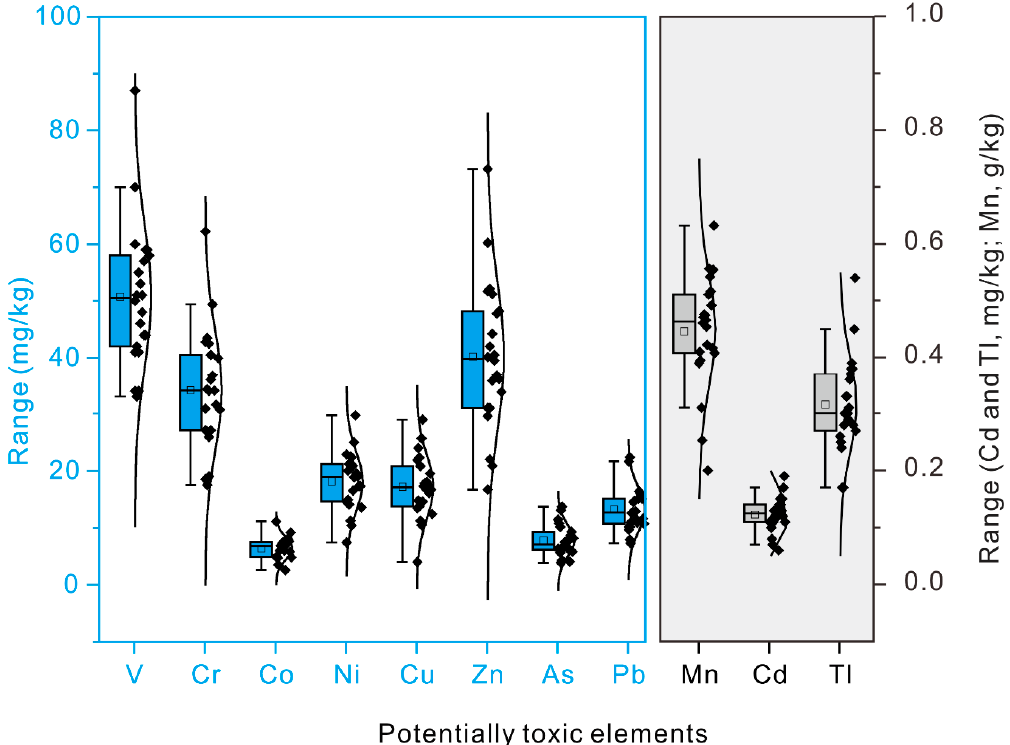
Figure 2. Statistical characteristics of the potentially-toxic elements (PTEs) in the Bosten Lake surface sediments. The plots for PTEs in black box and transparent box were used di ff erent vertical coordinates.